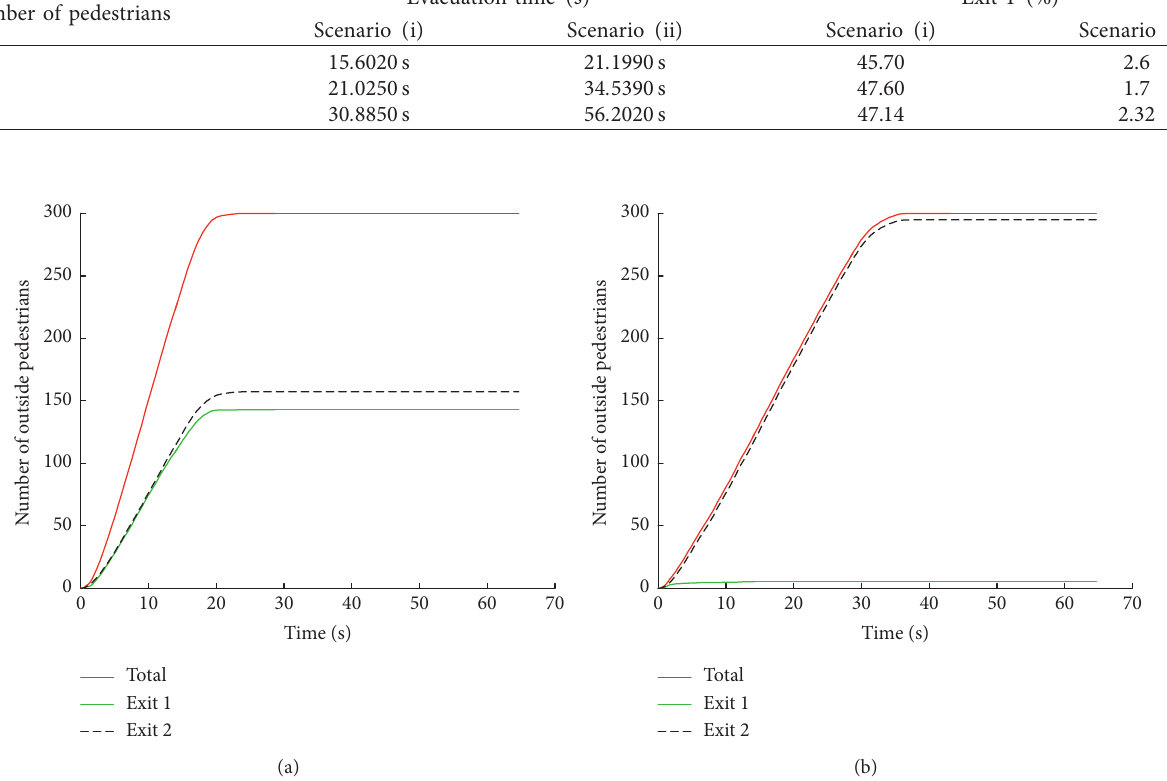
Figure 4: Number of outside pedestrians of scenario (i) and scenario (ii). Total number of pedestrians is 300. (a) Source is in the middle and (b) source is near Exit